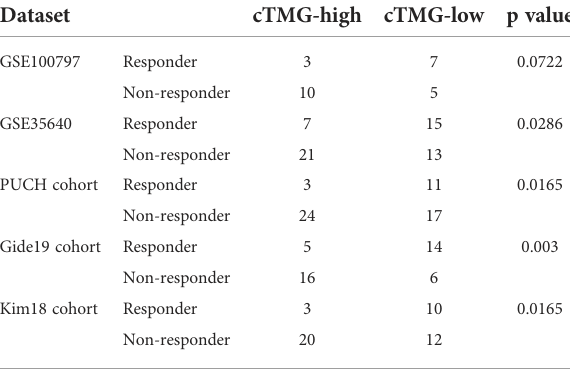
TABLE 1 Response to immunotherapies of cTMGs-strati fi ed groups.